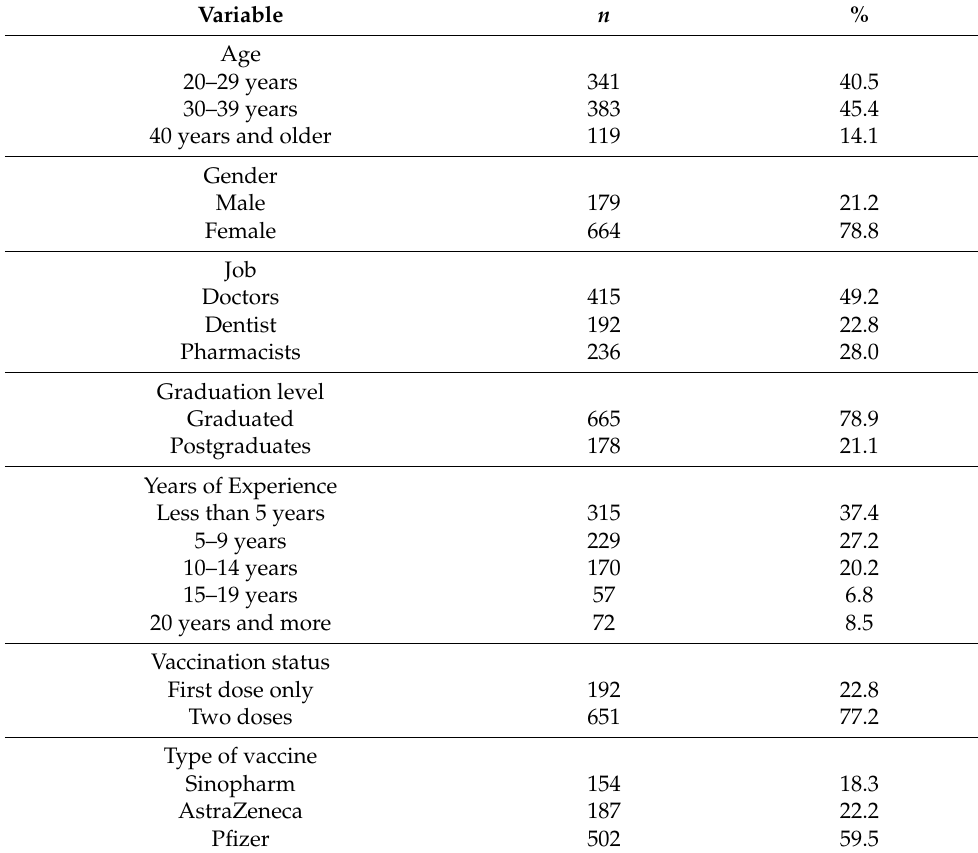
Table 1. Basic demographic characteristics of study